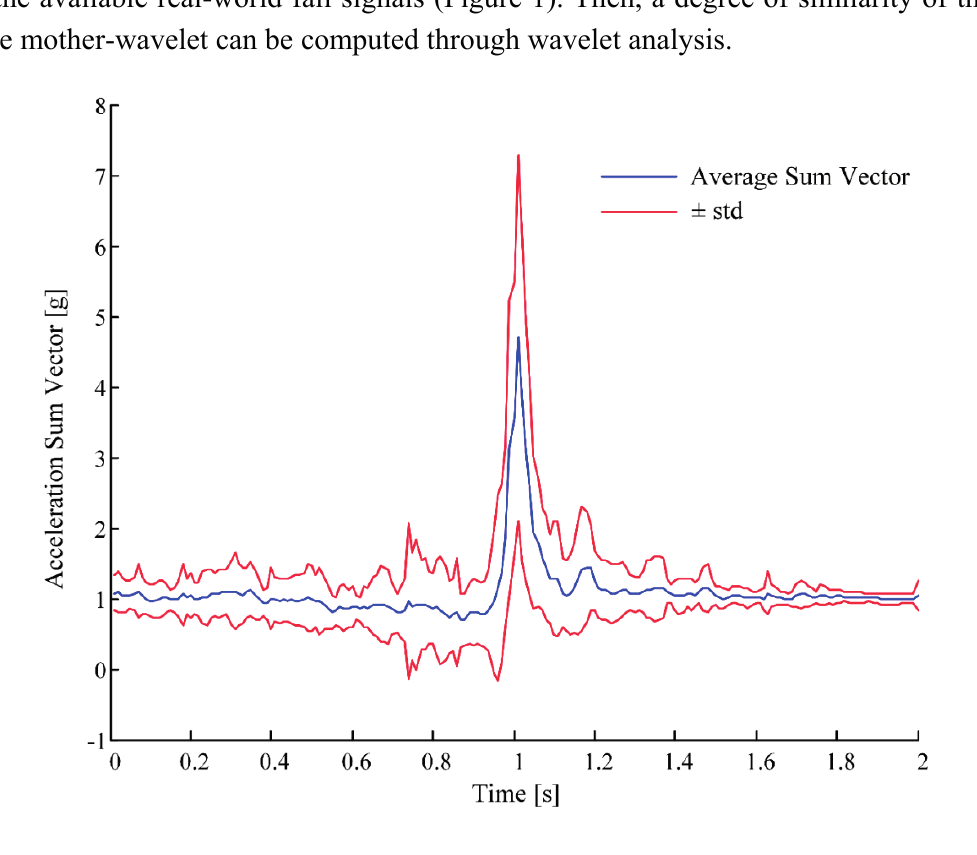
Figure 1. Average (±1 standard deviation) acceleration sum vector (centered on the peak) over the 29 real-world